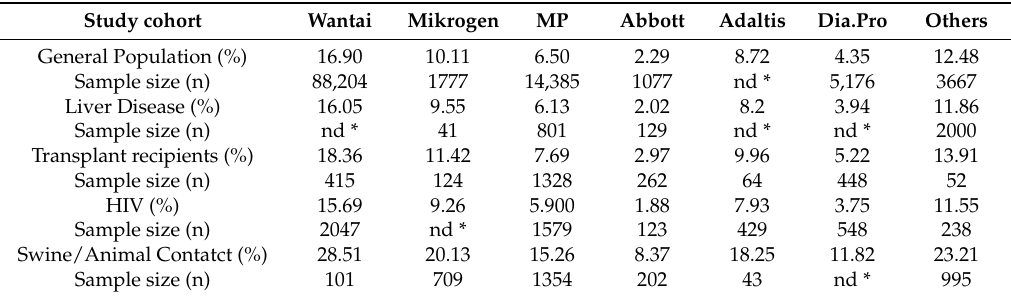
Table 1. Anti-HEV IgG seroprevalence rates determined by different commercial assays for different study